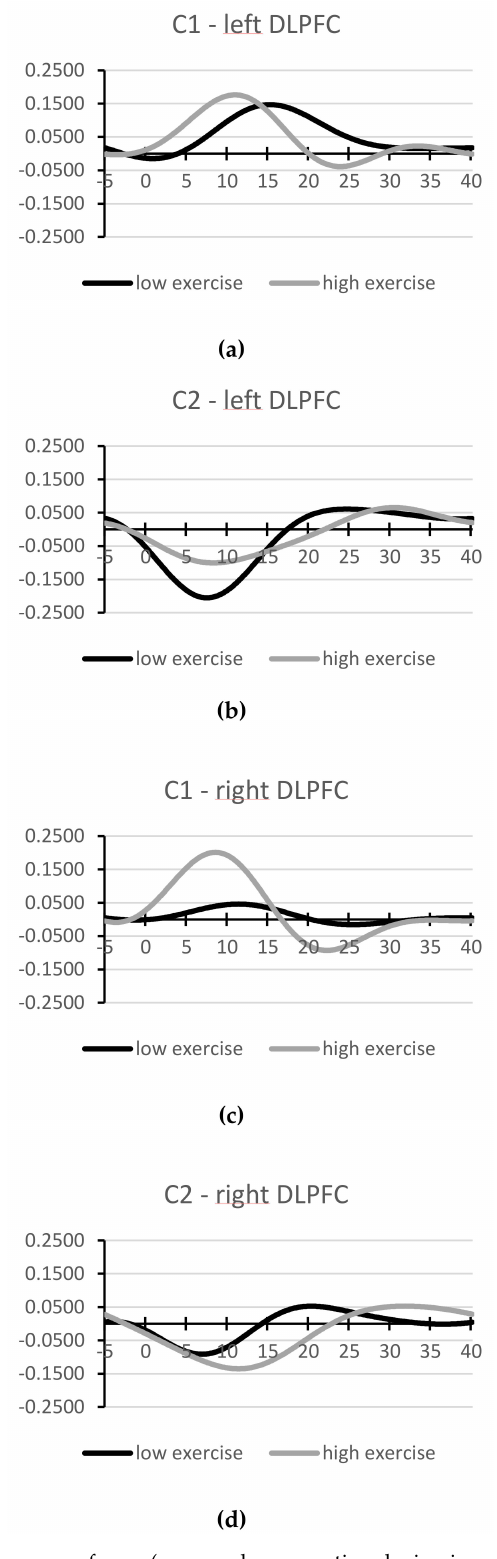
Figure 3. FNIRS interference waveforms (averaged oxygenation during incompatible test blocks minus compatible test blocks; in mmol / L) of the left dorsolateral prefrontal cortex before (a) and after the stressor (b), and of the right dorsolateral prefrontal cortex before ( c ) and after the stressor ( d